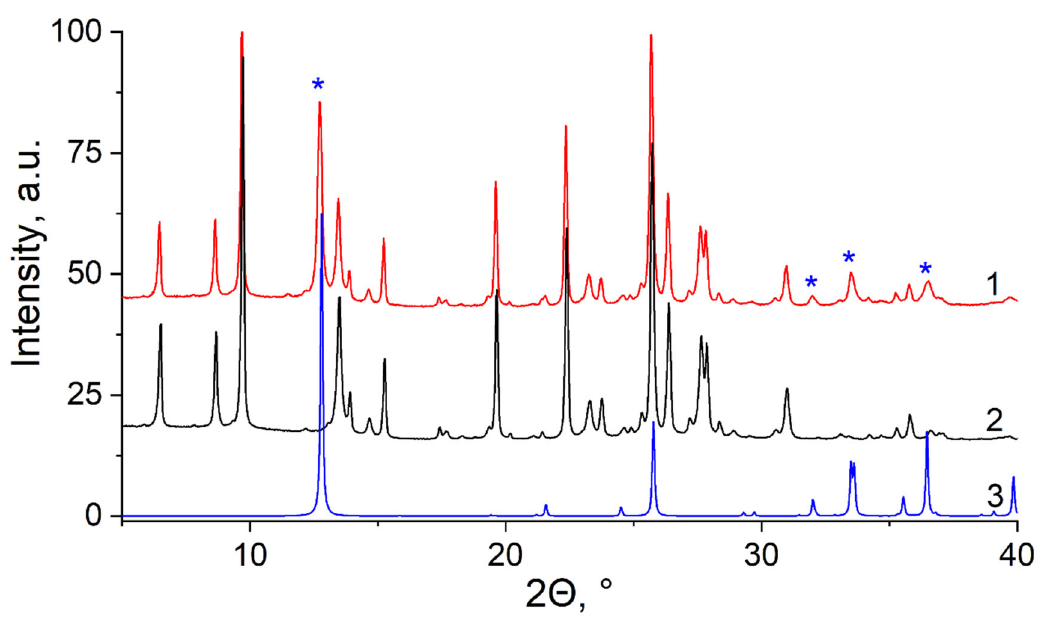
Figure 2. XRD patterns of Cu-MOR before activation (1), MOR (2), and Cu 2 (NO 3 )(OH) 3 before activation (3); patterns are offset for clarity, and peaks corresponding to phase (3) are marked with blue